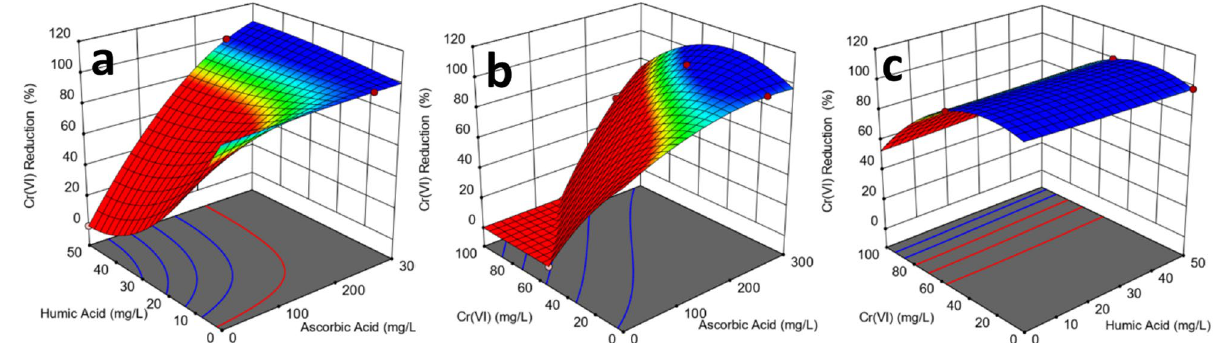
Figure 5. Response surface plots representing the interactive effects of ( a ) ascorbic acid and humic acid, ( b ) ascorbic acid and initial chromium concentration, and ( c ) humic acid and initial chromium concentration on the reduction of Cr(VI) in an aqueous